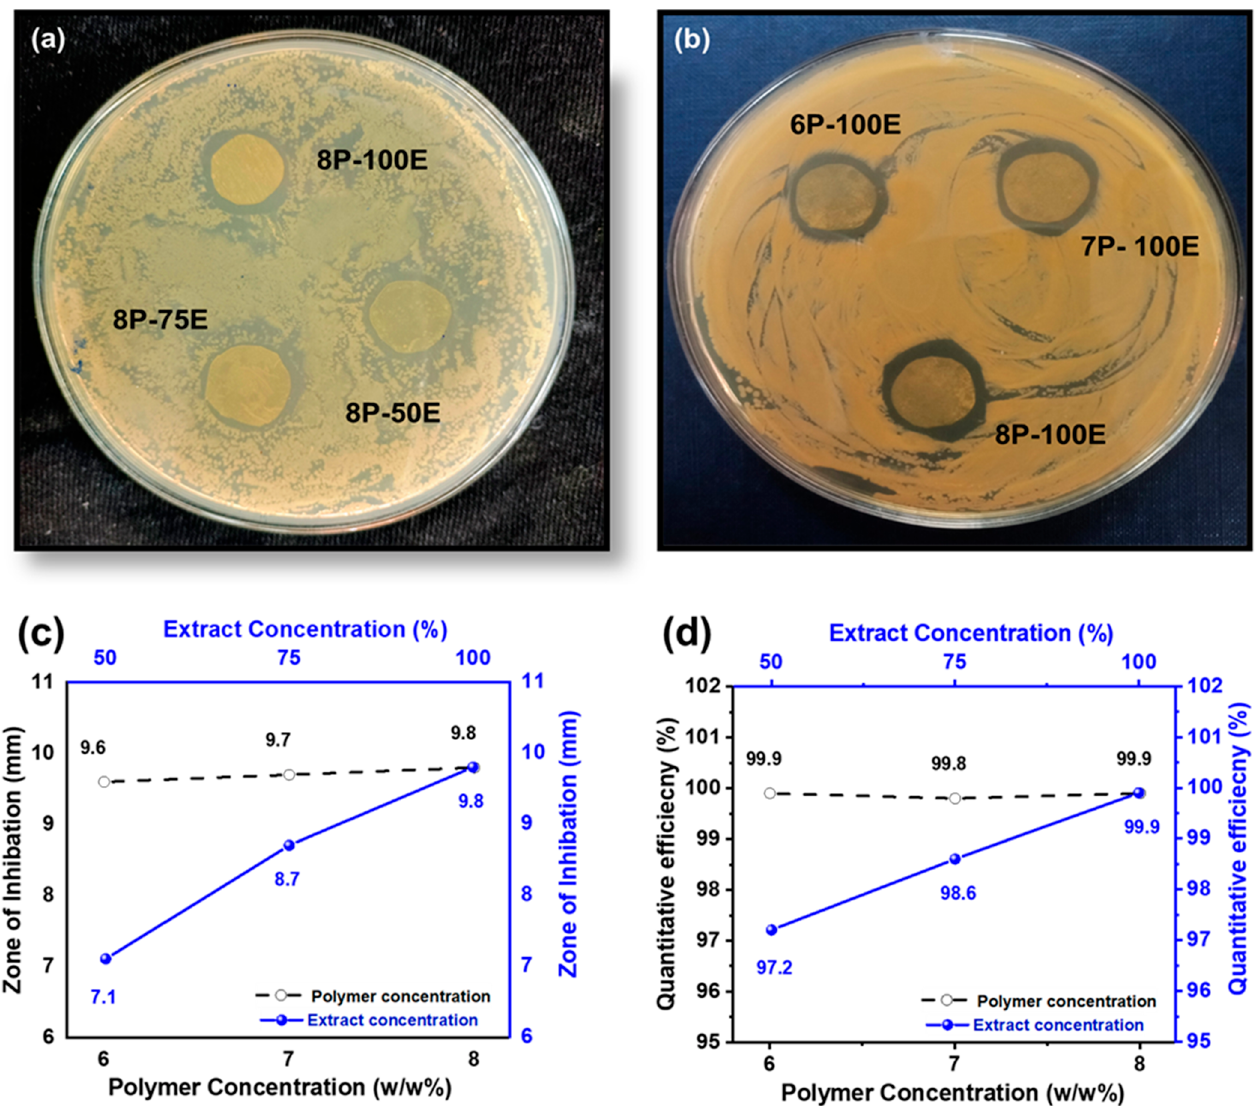
Figure 8. Effect of PVA wt./wt. %age and AI extract concentration ( a – c ) on the zone of inhibition through the disc diffusion method ( d ) quantitative efficiency via the colony-forming method .